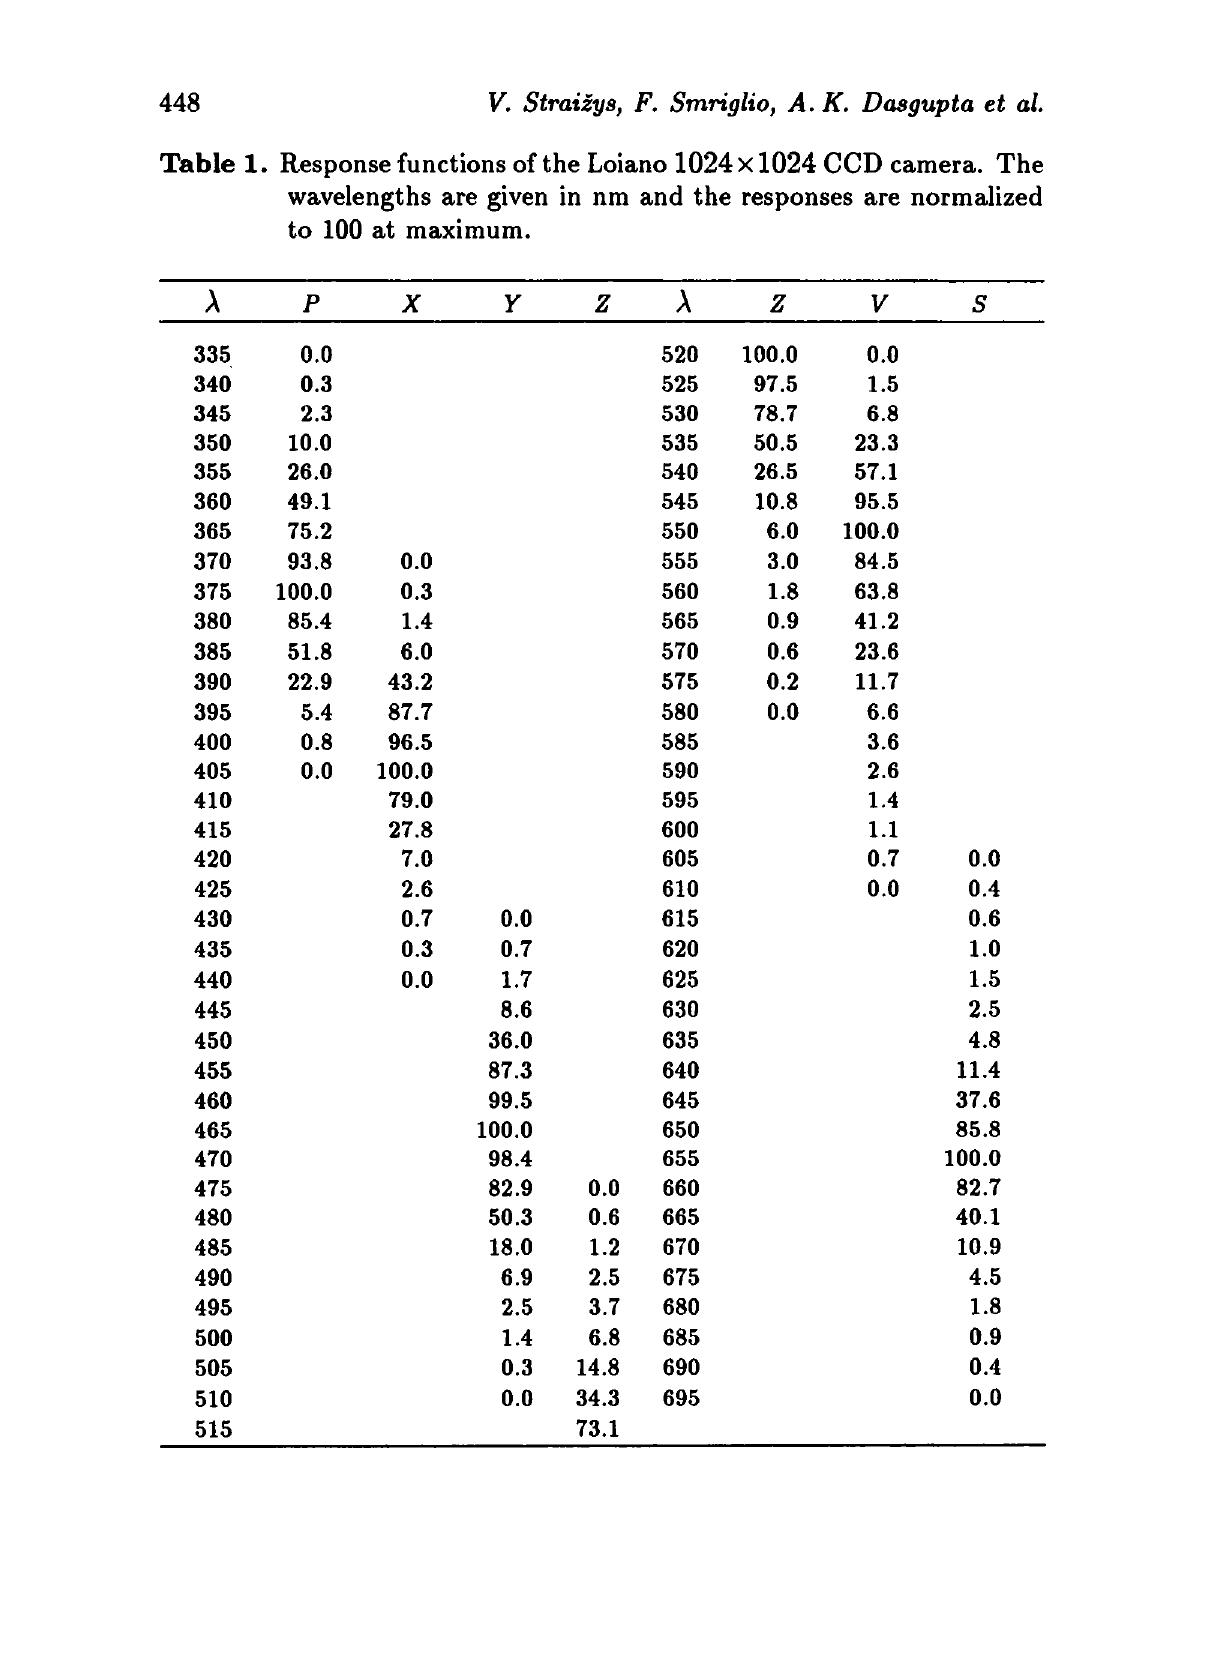
Table 1. Response functions of the Loiano 1024x1024 CCD camera. The wavelengths are given in nm and the responses are normalized to 100 at